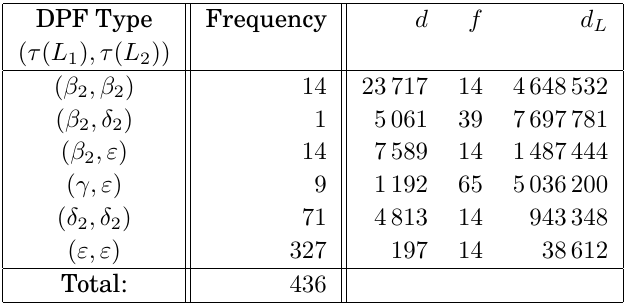
Table 21: Types of doublets with a split prime divisor of regular f .